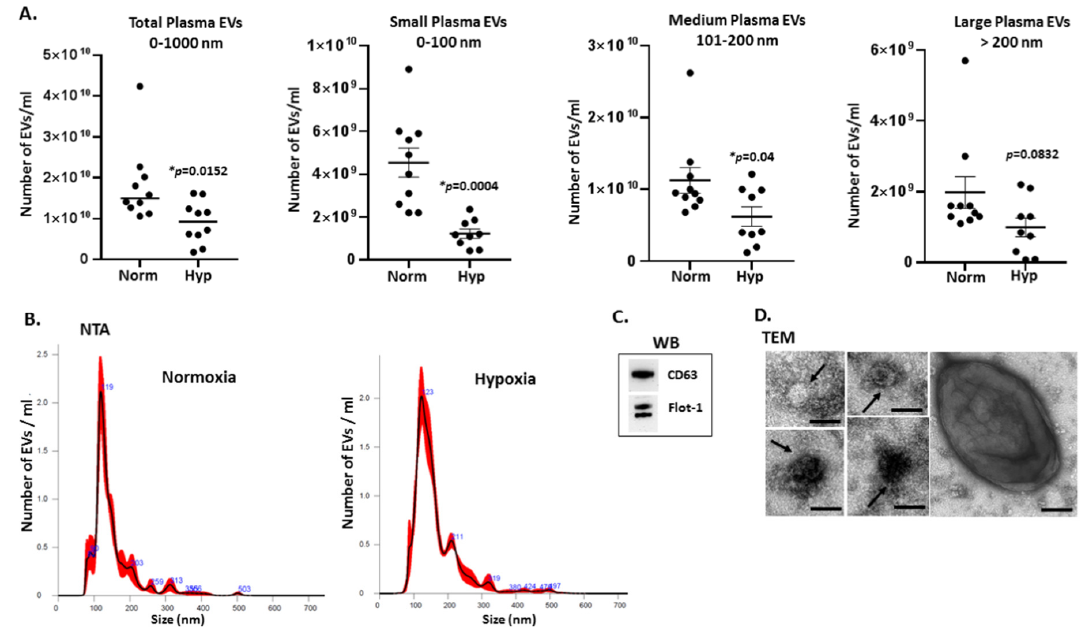
Figure 1. EV profile trends from plasma of naked mole-rats treated for 4 h in normoxia or hypoxia. ( A ) Number of EVs isolated from naked mole-rat plasma, comparing normoxia and hypoxia conditions. Changes were assessed in release profiles of total EVs (0–1000 nm), small EVs (<100 nm), medium-sized EVs (101–200 nm) and large EVs (201–1000 nm); based on measurement of plasma EVs from 10 animals per group; error bars represent standard error of mean (SEM); t -test, exact p -values are shown, p < 0.05 considered statistically significant (indicated by *). ( B ) Representative NTA curves of plasma EVs from naked mole-rats following normoxia or hypoxia treatment, respectively; ( C ) Western blotting analysis of EV markers for naked mole-rat plasma EVs, showing positive for CD63 and Flotillin-1; ( D ) Transmission electron microscopy (TEM) of plasma-EVs from naked mole- rats, showing representative images of the differently sized EVs; scale bar indicates 100 nm, black arrows highlight individual